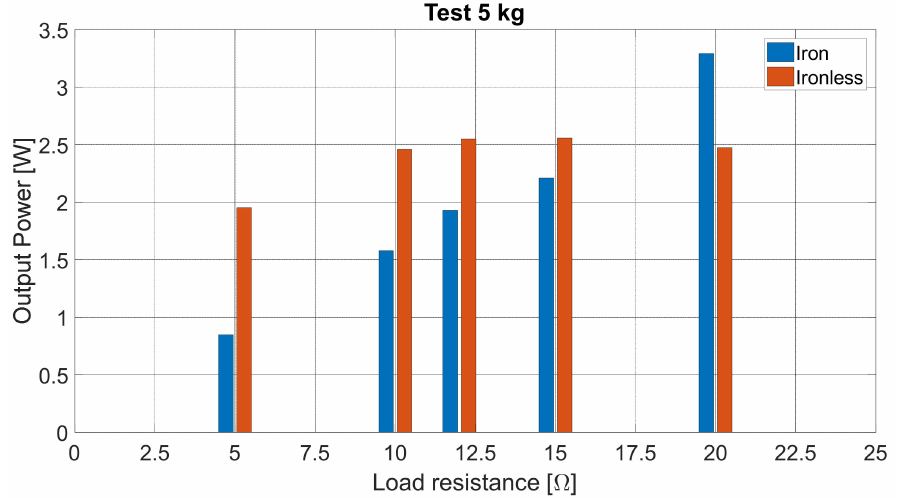
Figure 24. Power transferred to the electric loads at 5 kg by the two PMLG prototypes.